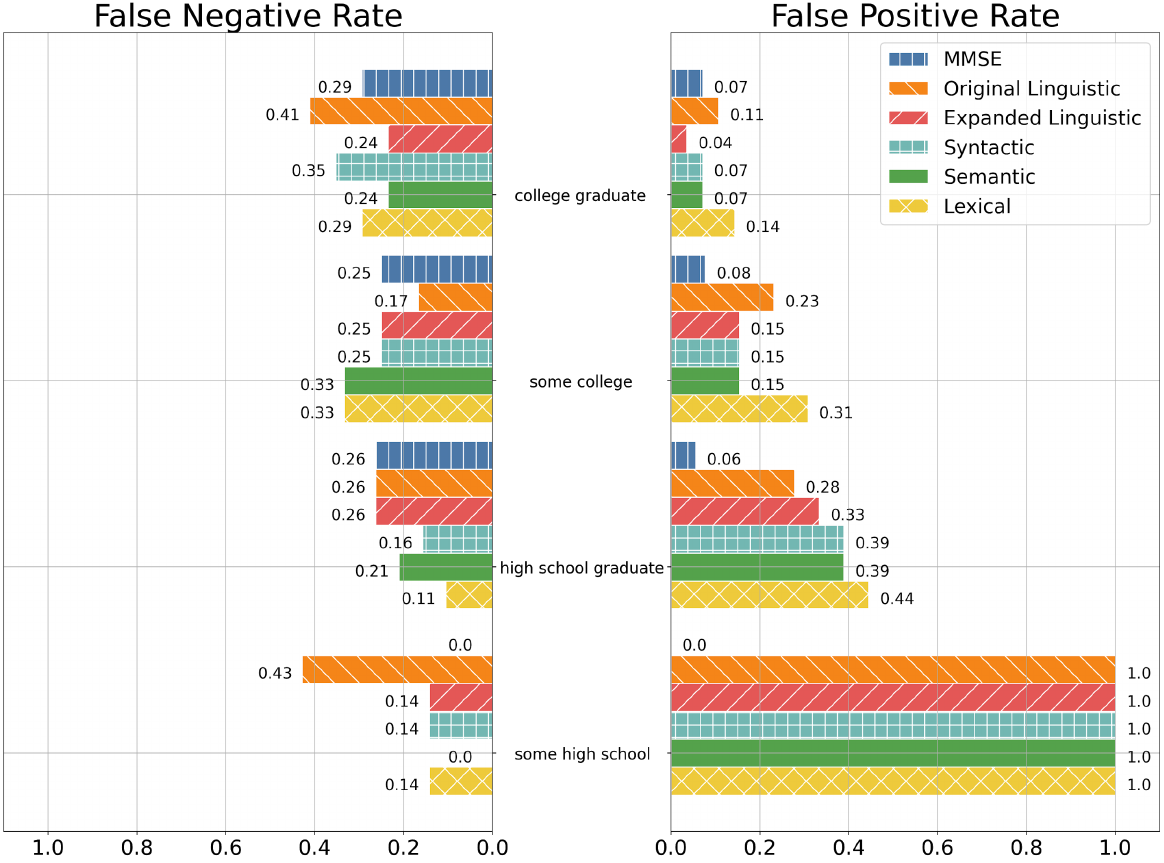
Figure 1. FNR and FPR of the MMSE, Baseline Linguistic, Expanded Linguistic, Expanded Syntactic, Expanded Semantic, and Expanded Lexical feature sets among education groups. Note: Lack of a bar denotes a rate of 0. Education group encoding is as follows: 0—High School, did not graduate; 1—High School; 2—Some College; 3—College Graduate. Education group 0 only